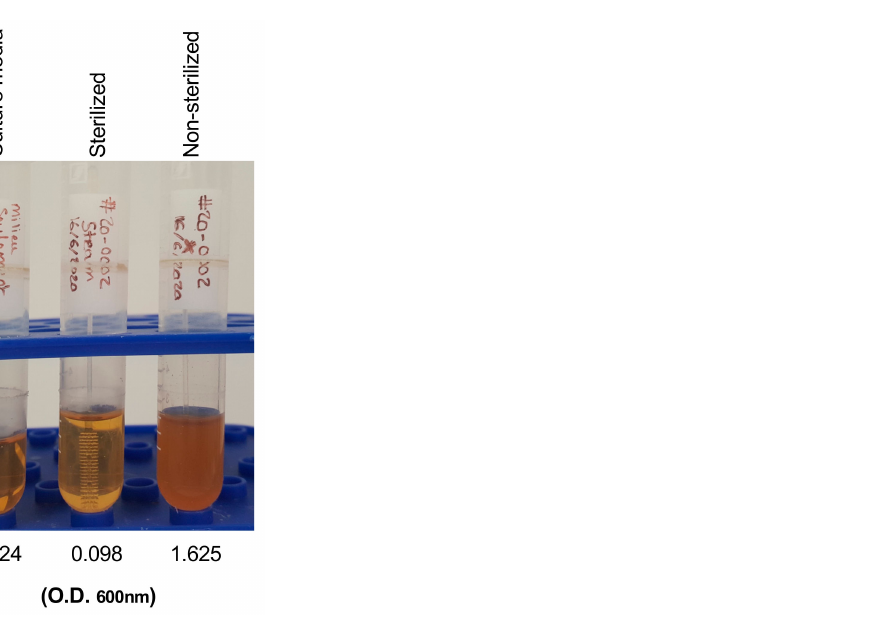
Figure 2. Validation of 3D-printed swab sterilization. Swab heads inoculated with G. stearother- mophilus spore suspension before sterilization cultured in soy broth culture media. Bacteria growth was assessed by measuring the optical density (O.D.) at 600 nm. Culture media alone was used as negative control.